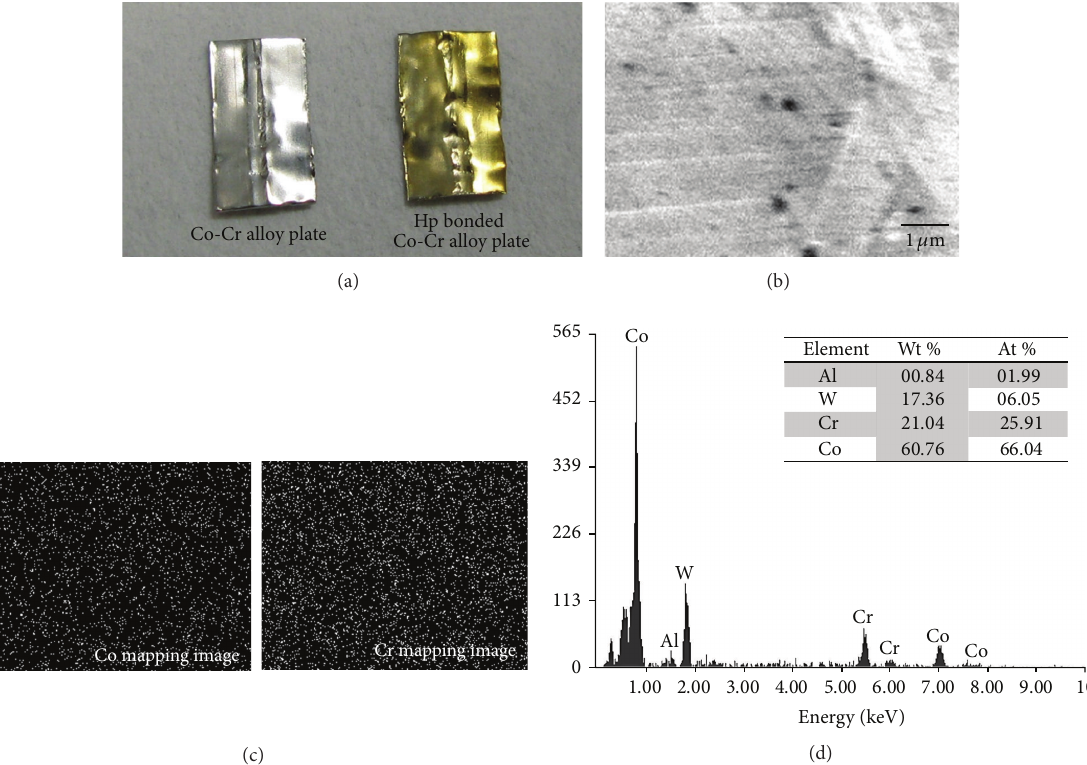
Figure 1: (a) Photograph, (b) FE-SEM image, (c) EDS mapping images, and (d) elemental analysis of Co-Cr alloy